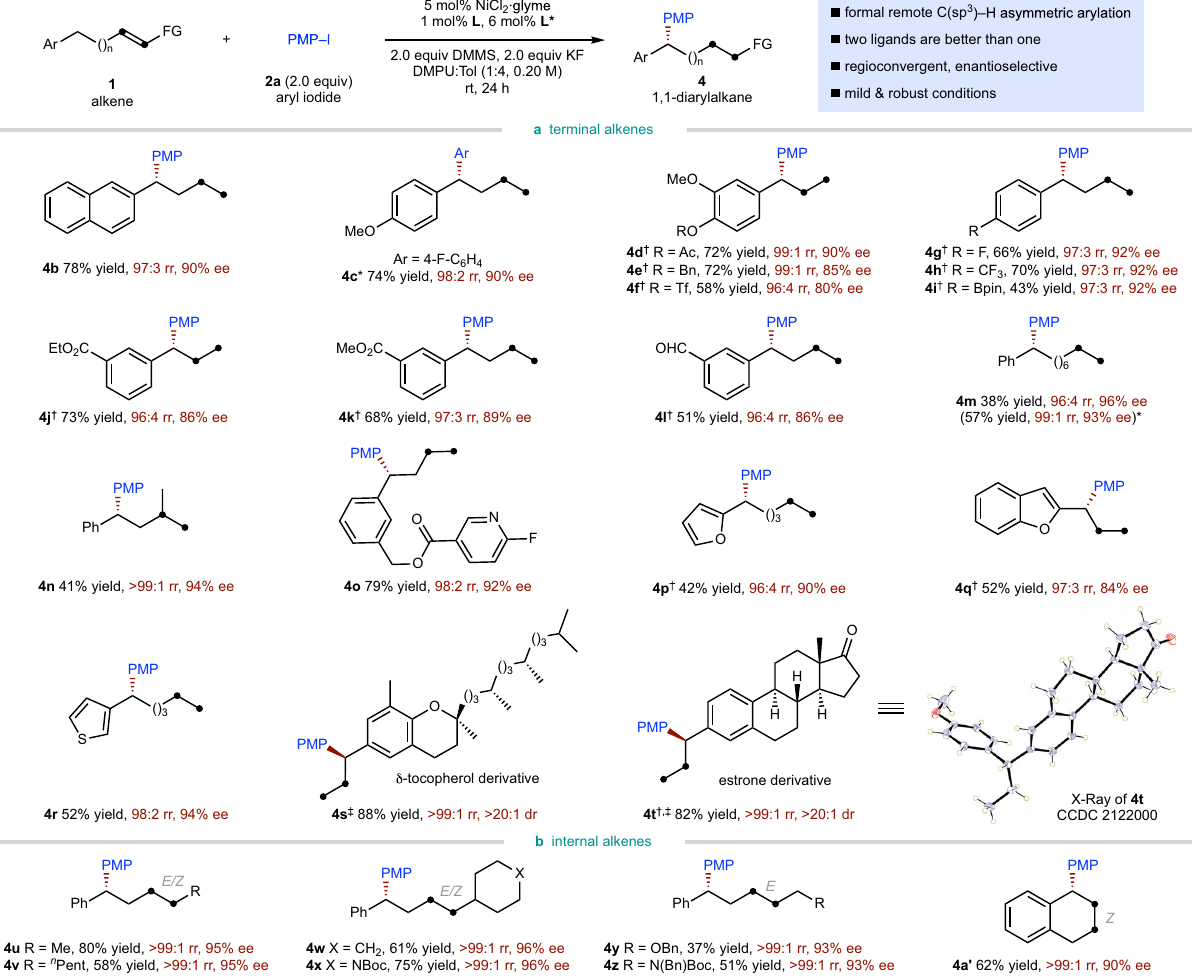
Fig. 4 Substrate scope of alkene coupling component. Under each product is given yield in percent, regioisomeric ratio (rr), and either the enantioselectivities (ee) or the diastereomeric ratio (dr). Yield, rr and ee are as de fi ned in Fig. 3 legend. *2% L used. † 0.4% L used. ‡ Diastereoselectivity (dr) determined by 1 H NMR analysis of the crude reaction